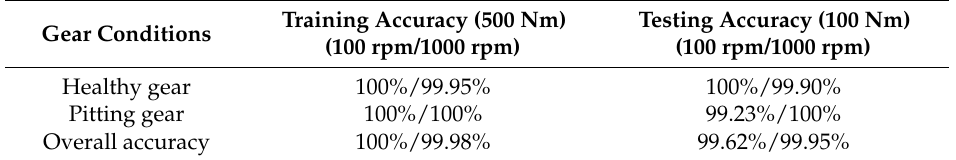
Table 4. Detection results at 100 and 1000 rpm (trained with heavy loading samples and tested with light loading samples).